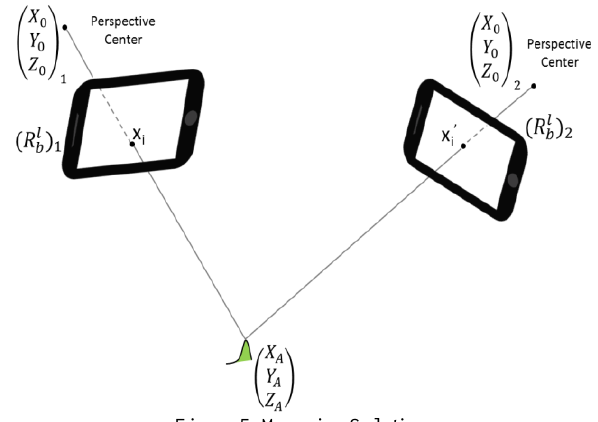
Figure 5. Mapping Solution